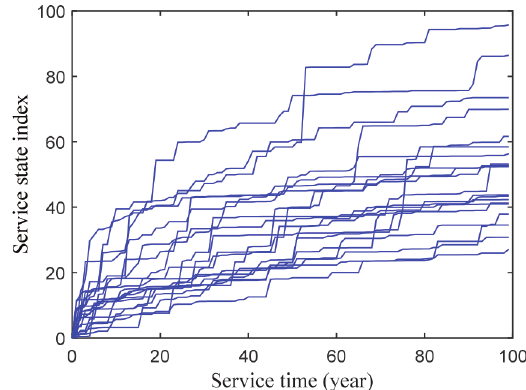
Figure 4. Simulating the variation of degradation rate by non-stationary Gamma